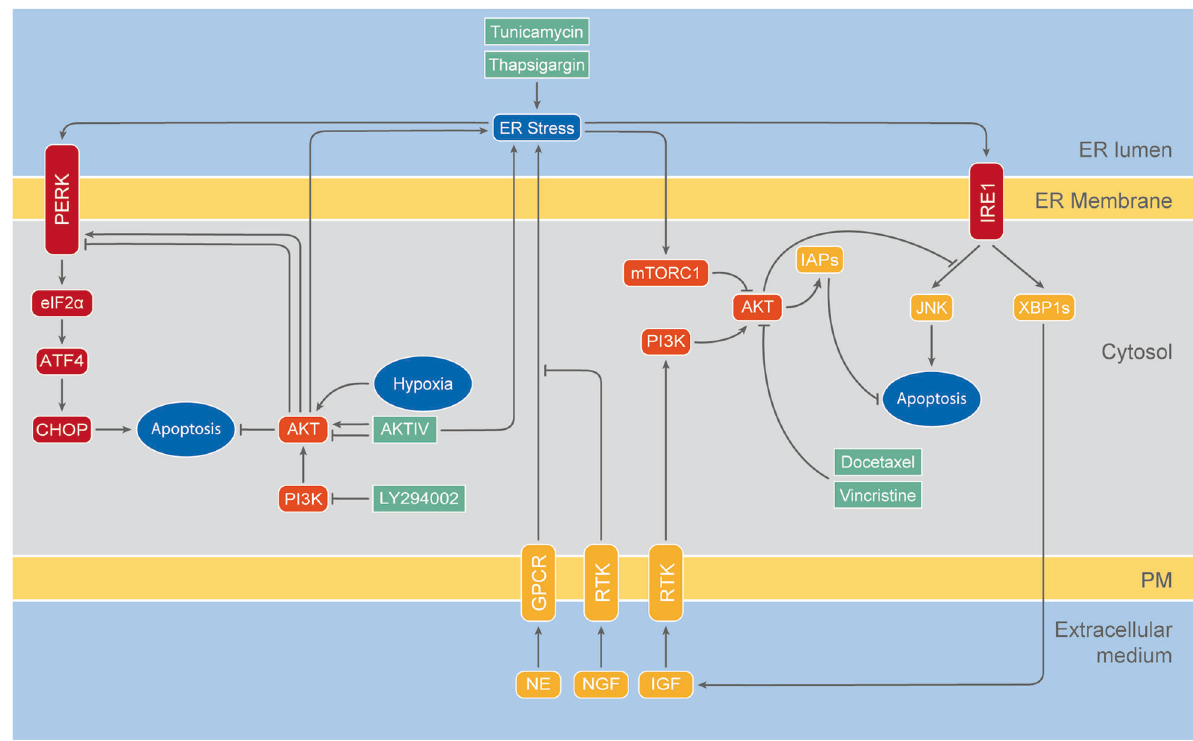
Fig. 3 Crosstalk between the AKT and the UPR pathways. The main interactions between both signaling pathways are shown, together with the main biological processes regulated by these pathways. Pharmacological compounds targeting these feedback loops with a potential therapeutic role in SARS-CoV-2 infection are listed